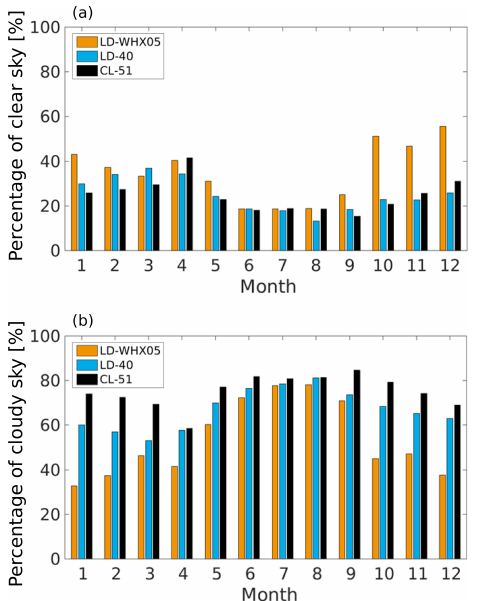
Figure 4. Annual cycle of the detected occurrence frequency of clear-sky conditions (a) and cloudy conditions (b) , given in per- cent of the total monthly observation times. The average monthly percentage is retrieved from monthly mean values excluding the in- strumental overlap months July 1998 and August 2011 as well as months with less than 75% data coverage. The 25-year observa- tion period is presented in the subsets August 1992 to June 1998 (orange), August 1998 to June 2011 (blue), and September 2011 to July 2017 (black) according to the different ceilometer types.